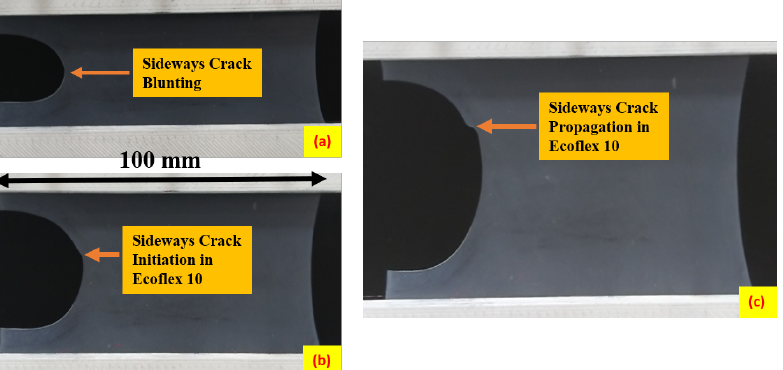
Figure 3. Representation of sideways crack propagation of Ecoflex 10 of thickness 3.6 mm at a strain rate of 40 mm/min; ( a ) blunting of 20 mm sideways crack; ( b ) initiation of sideways crack; ( c ) propagation of sideways